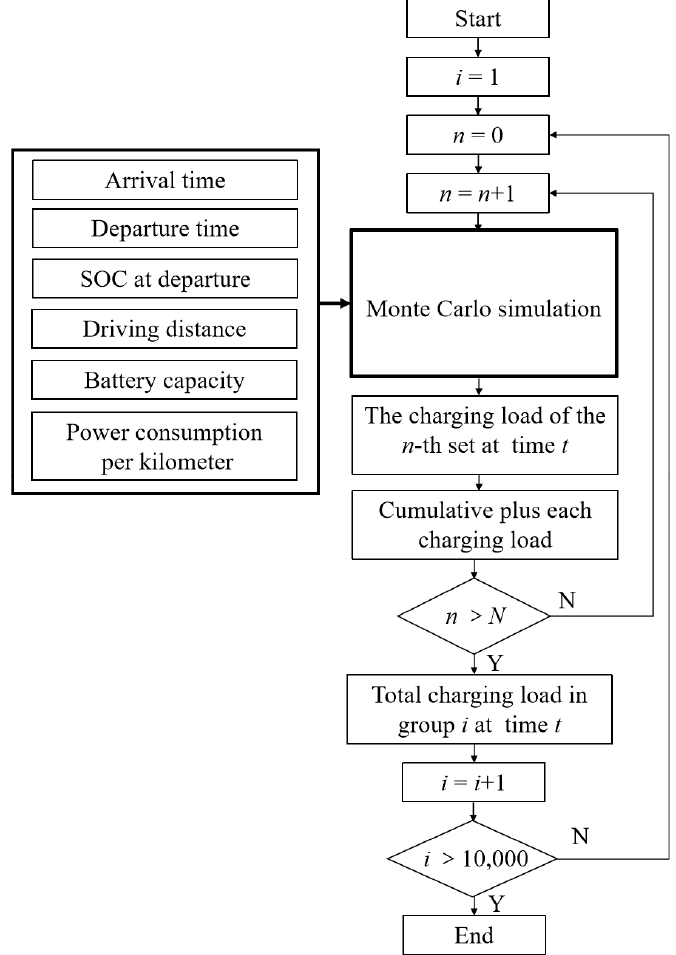
Figure 2. The charging load calculation process.